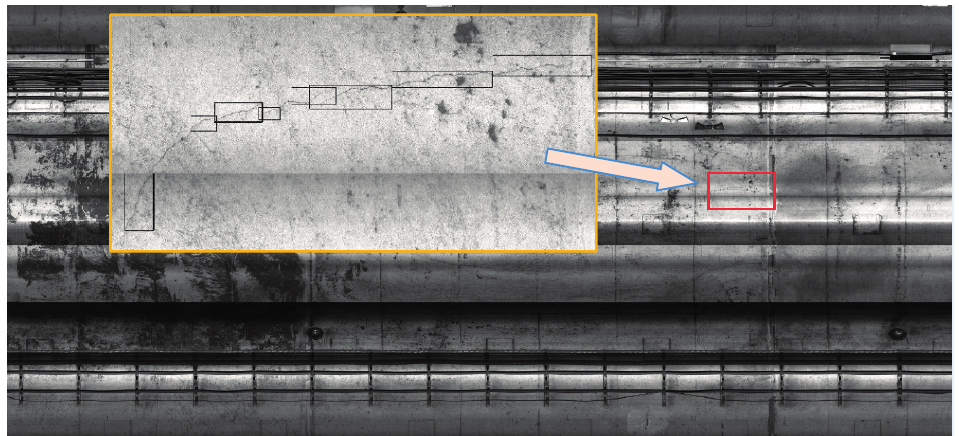
Figure 3. Example of a stitched